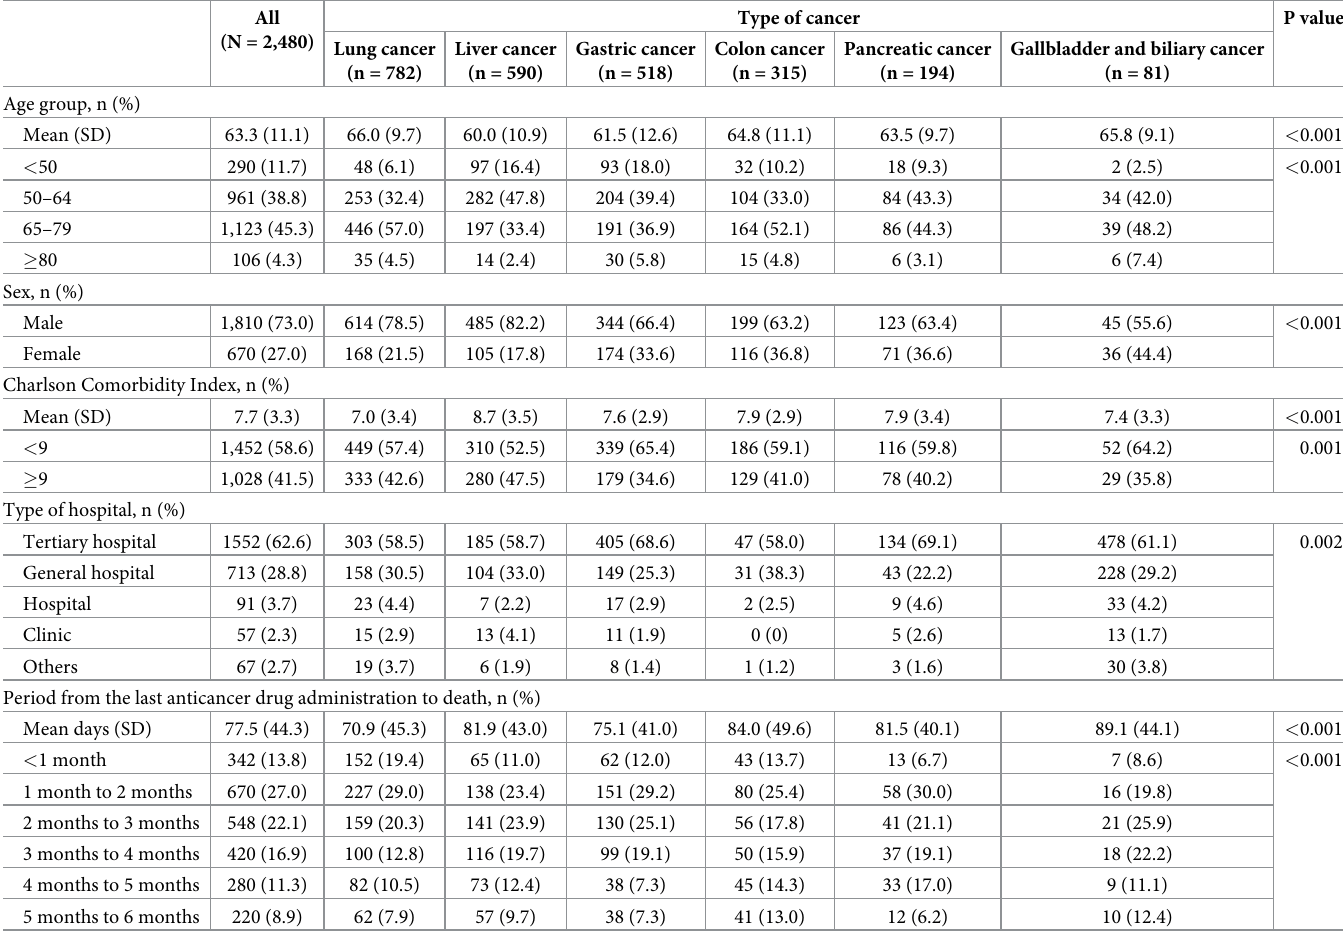
Table 1. Demographic characteristics of patients with terminal